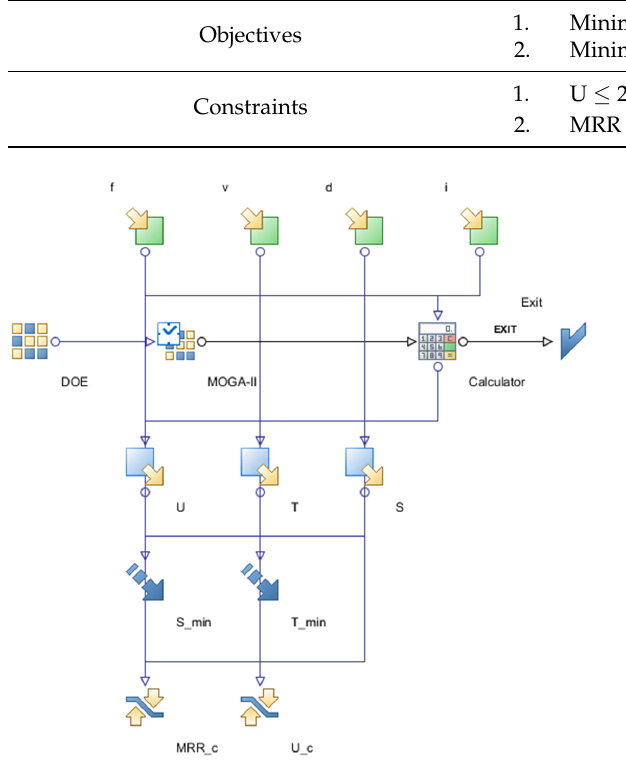
Figure 3. Optimization workflow showing all input and output